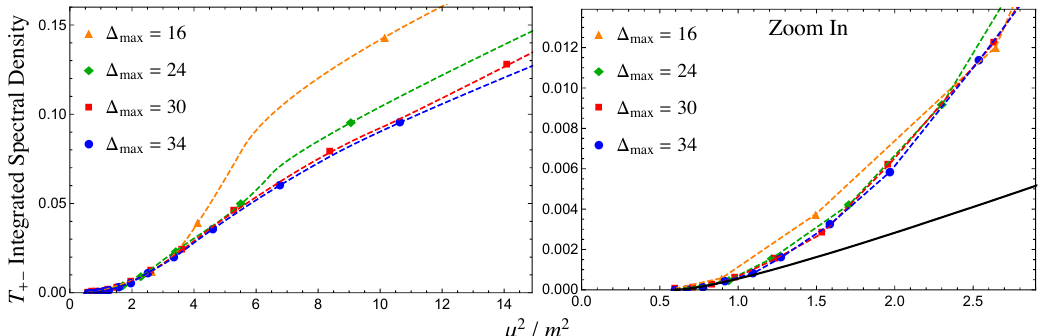
Figure 6 . Integrated spectral density for T + (cid:0) at di(cid:11)erent values of (cid:1) max . The (cid:1) max = 34 results (blue dots) are at (cid:22) (cid:21) = 1 : 96, and the couplings for the remaining results have been chosen such that 4 (cid:25) the mass gap remains (cid:12)xed. The points are the actual contributions of individual eigenstates to the spectral density, while the dashed lines are interpolations. The right plot is simply a zoomed- in version of the left one, and compares the conformal truncation results to the theoretical IR prediction for the Ising model (black